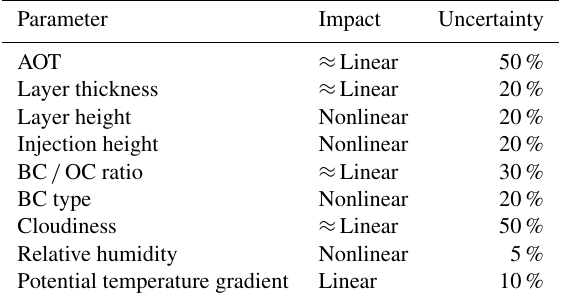
Table 1. Important input parameters in the self-lofting simulations, their influence on the results (in a linear or nonlinear way), and typ- ical uncertainties in the self-lofting results caused by uncertainties in these input parameters. More details are given in the